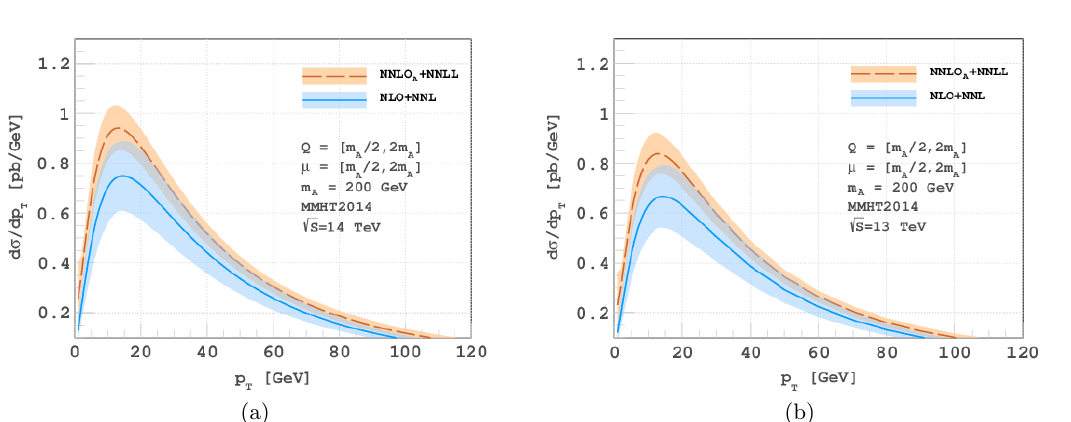
Figure 6 . Q, (cid:22) R and (cid:22) F variation at NLO+NLL and NNLO A +NNLL for (a) 14 TeV and (b) 13